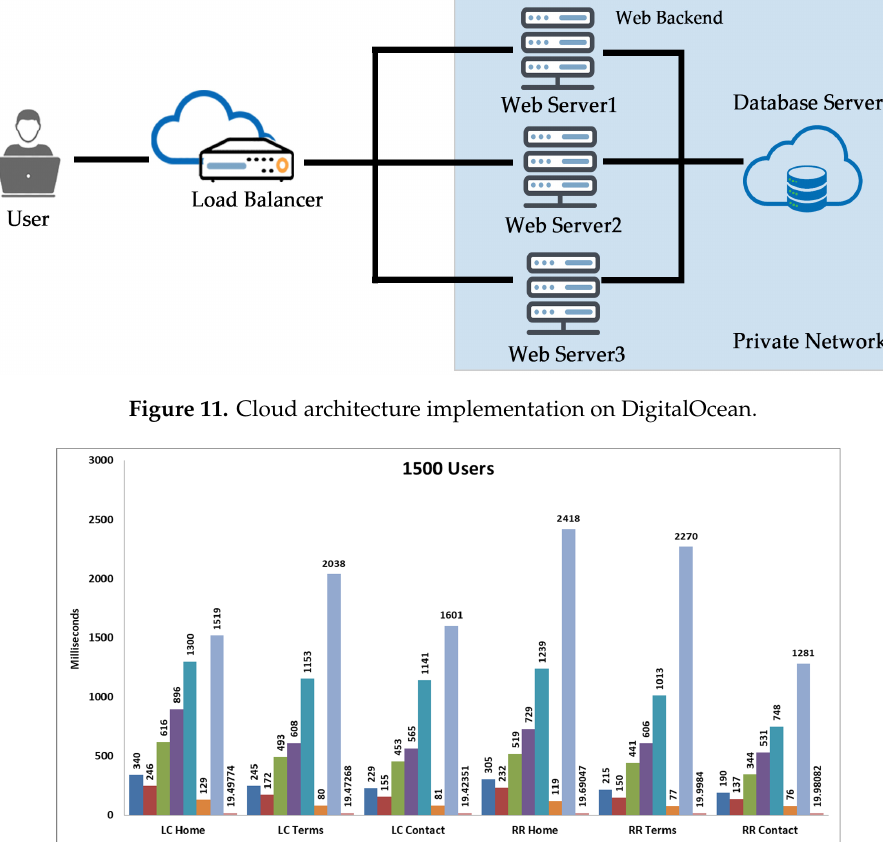
Table 4. Statistics table of the RR algorithm and LC algorithm for the first load test.